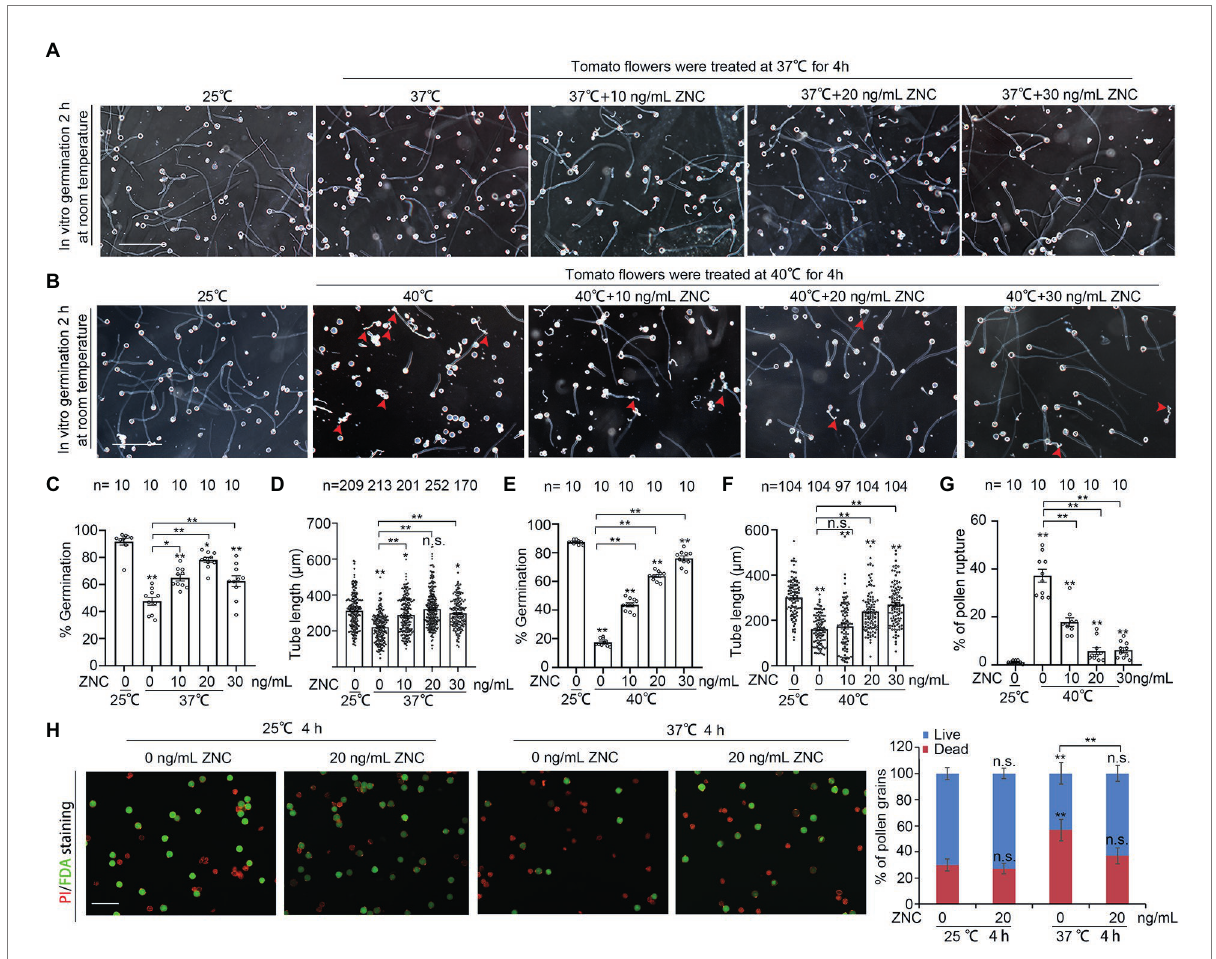
FIGURE 2 ZNC alleviates the decrease of pollen viability and pollen growth under short-term heat stress. (A,B) Effect of ZNC pretreatment on pollen growth under 4 h of 37 ° C or 40 ° C treatment. Scale bars, 200 μ m. (C,D) Quantification of pollen germination (C) , tube length at 37 ° C (D) in (A) . n denotes the number of observation views (C) and pollen tubes (D) . (E,G) Quantification of pollen germination (E) , tube length (F) and pollen rupture at 40 ° C in (G,B) . Red arrows indicate ruptured pollen. n denotes the number of observation views (E,G) and pollen tubes (F) . Supplementary Figure S2 shows the effect of ZNC at different concentration under 25 ° C. (H) Dual-staining of FDA and PI shows the effect of ZNC pretreatment on